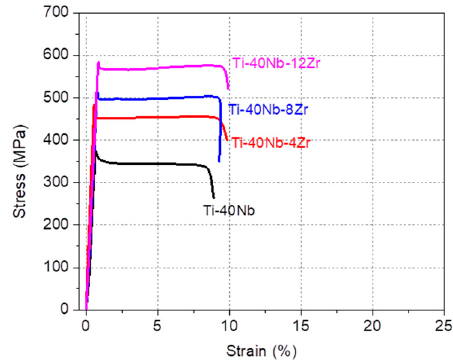
Figure 6. Stress-strain curves of Ti–40Nb and Ti–40Nb–(4, 8, 12) Zr alloys obtained at room temperature.